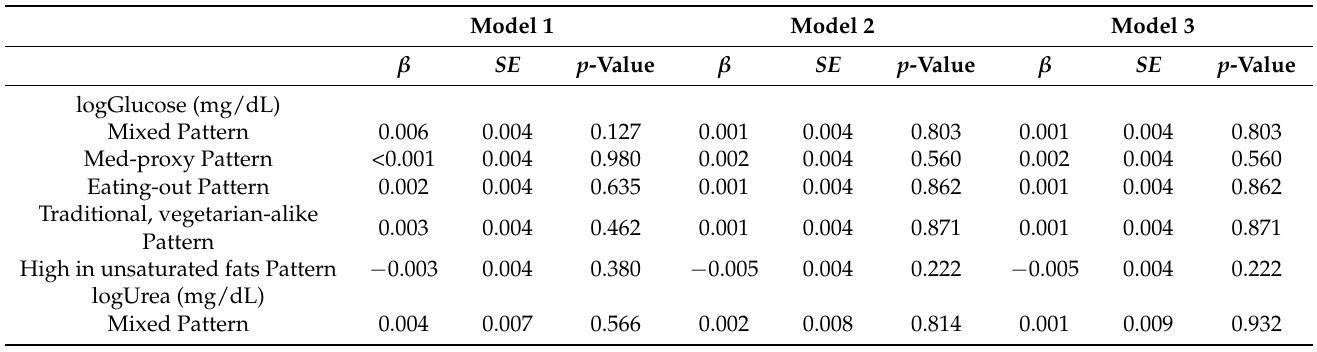
Table A1. Multivariate linear regressions between the extracted dietary patterns and indices of anthropometric and biochemical